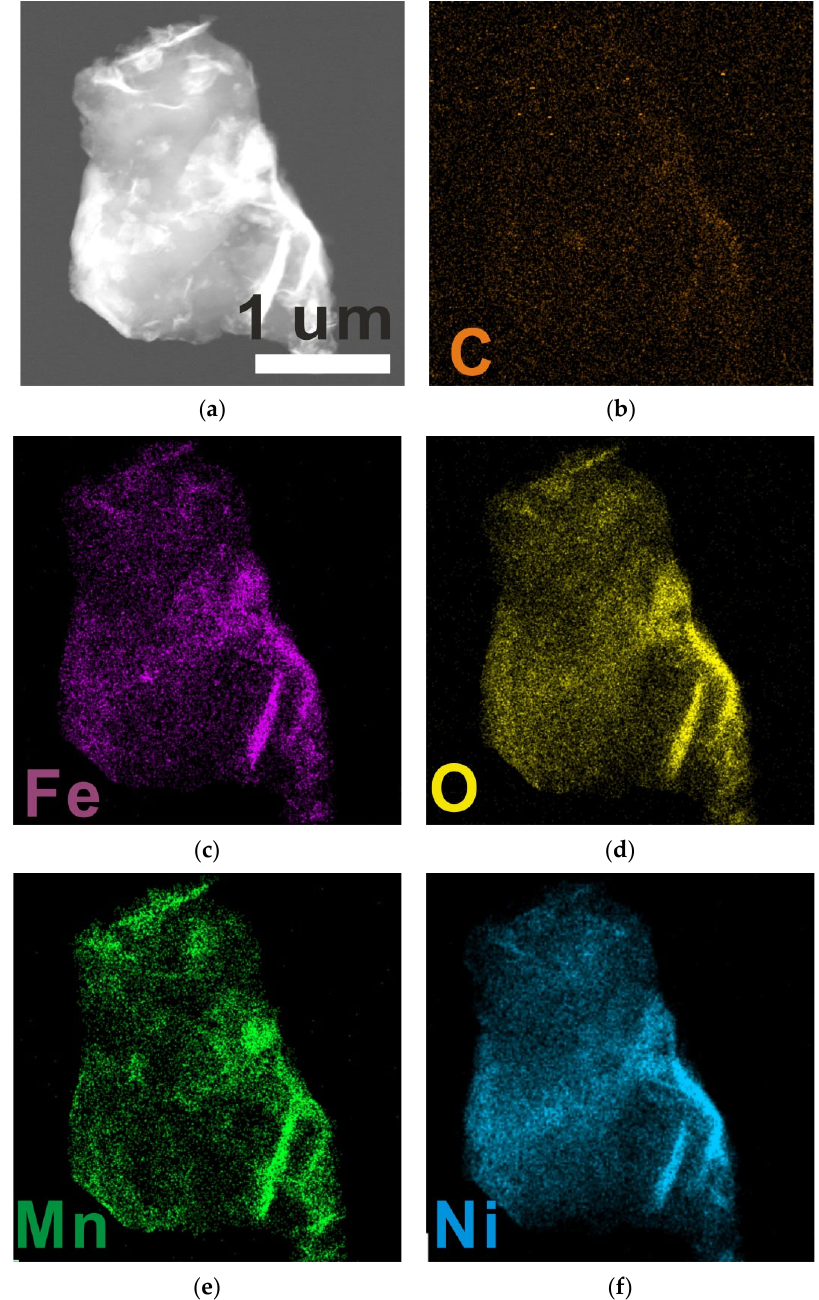
Figure 3. Elemental mapping of ( a ) NFM LDH/OOH-G and the distribution of ( b ) C, ( c ) Fe, ( d ) O, ( e ) Mn, and ( f ) Ni.